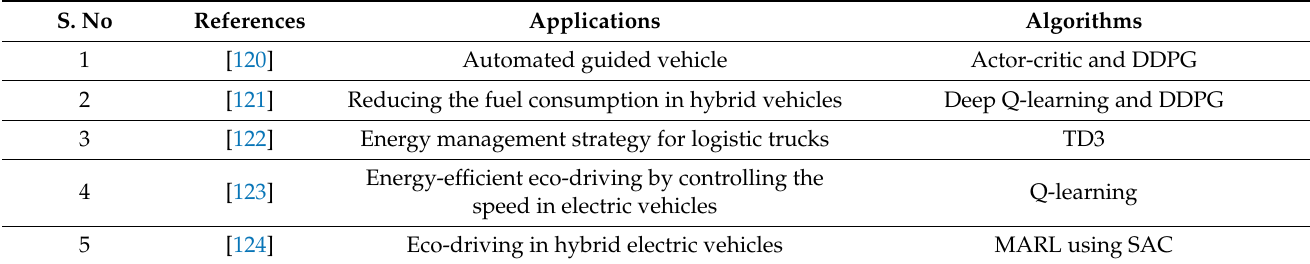
Table 5. Reinforcement learning applications of energy management in vehicles.